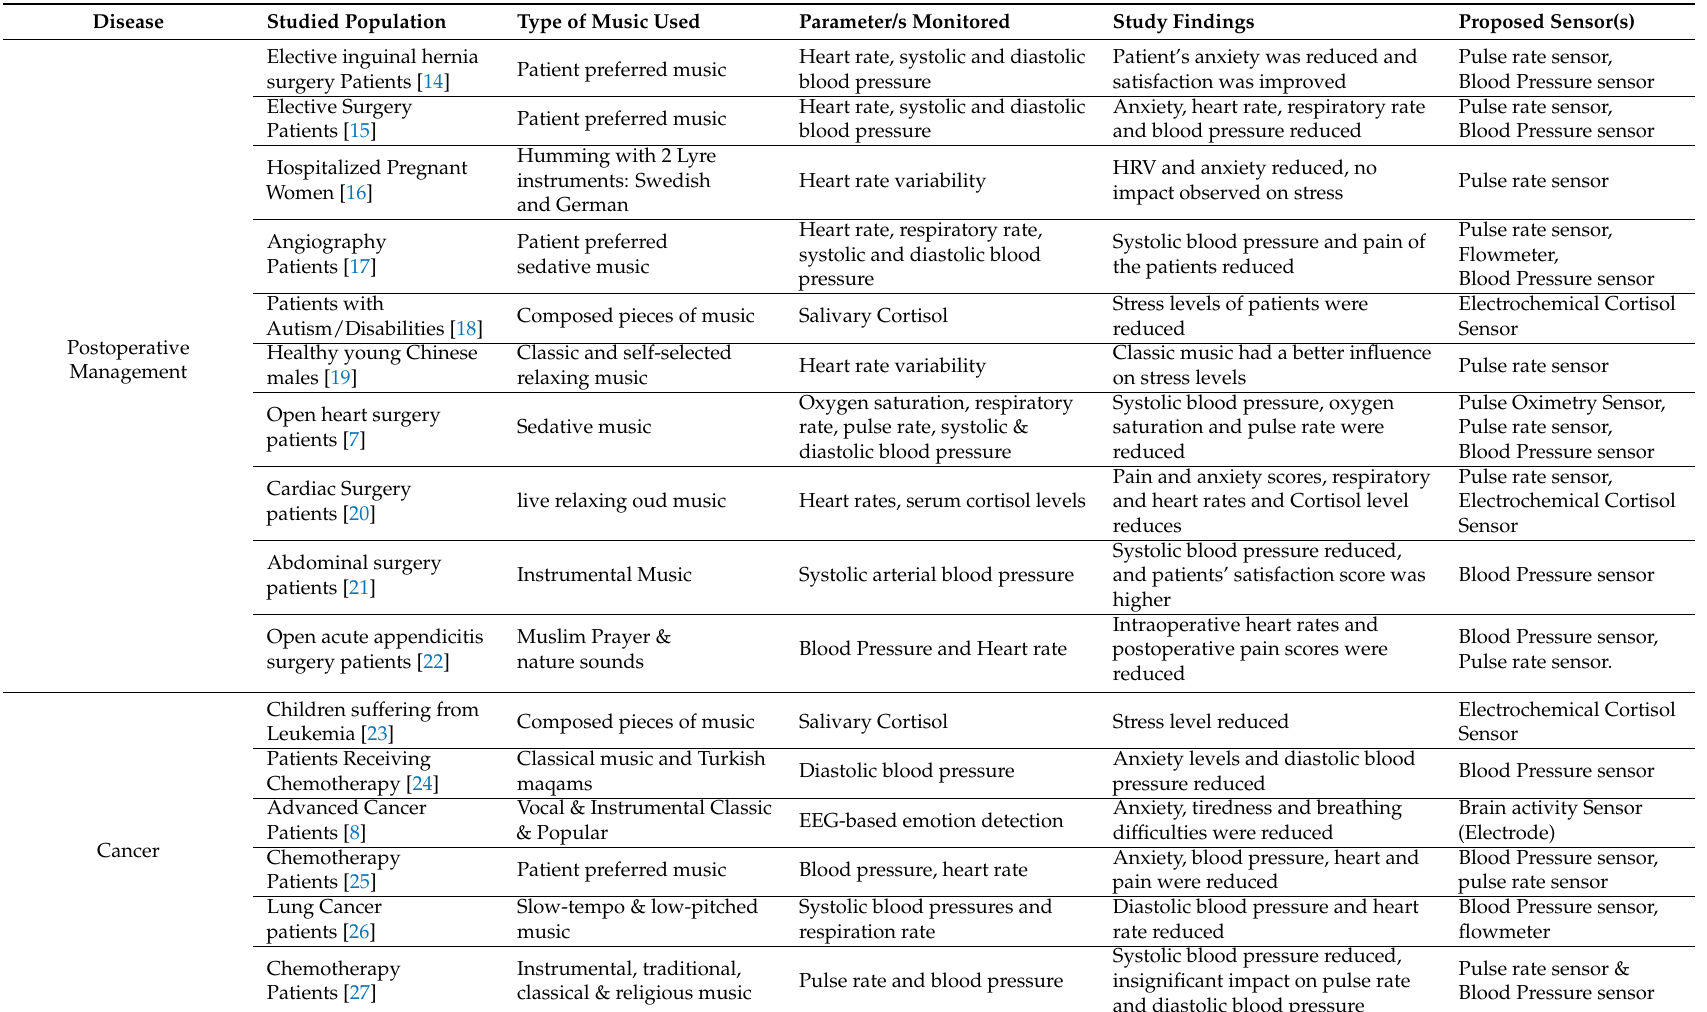
Table 1. State of the art: Diseases, Music Therapy, Monitored Parameters and